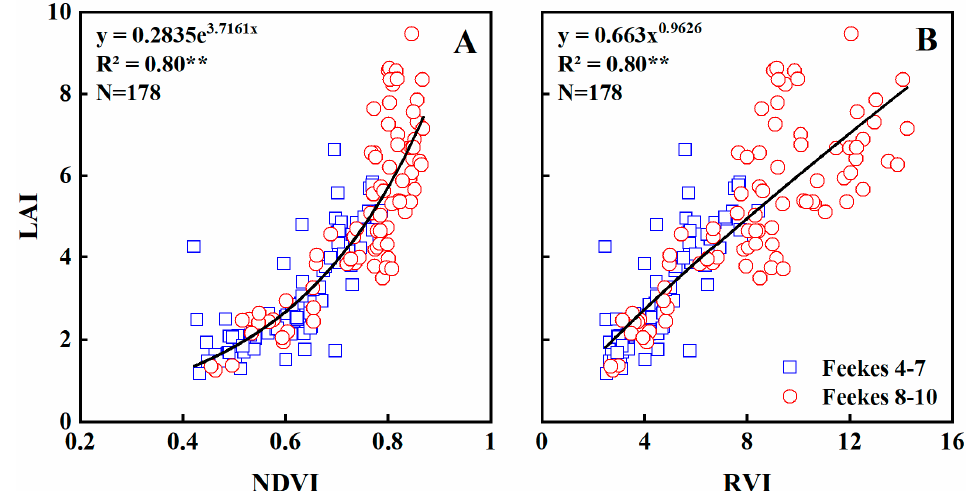
Figure 2. Quantitative relationships of NDVI ( A ) and RVI ( B ) to LAI in wheat varieties under varied N rates across all growth stages.